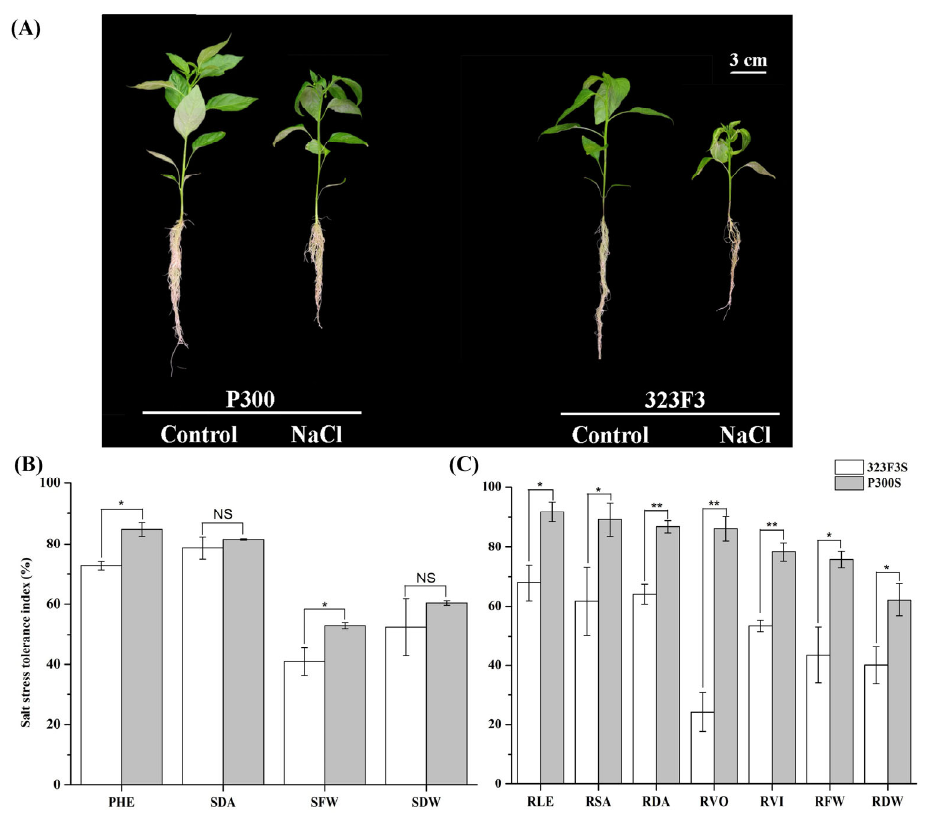
Figure 1. Performance of 323F3 and P300 seedlings in response to salt stress. ( A ) Phenotypes after 20 d salinity stress with 150 mM NaCl. ( B , C ) Salt stress tolerance index of different parameters from the shoot and root, respectively. Each bar represents three biological replicates ± SD. * p < 0.05; ** p < 0.01; NS, not significant (according to one-way